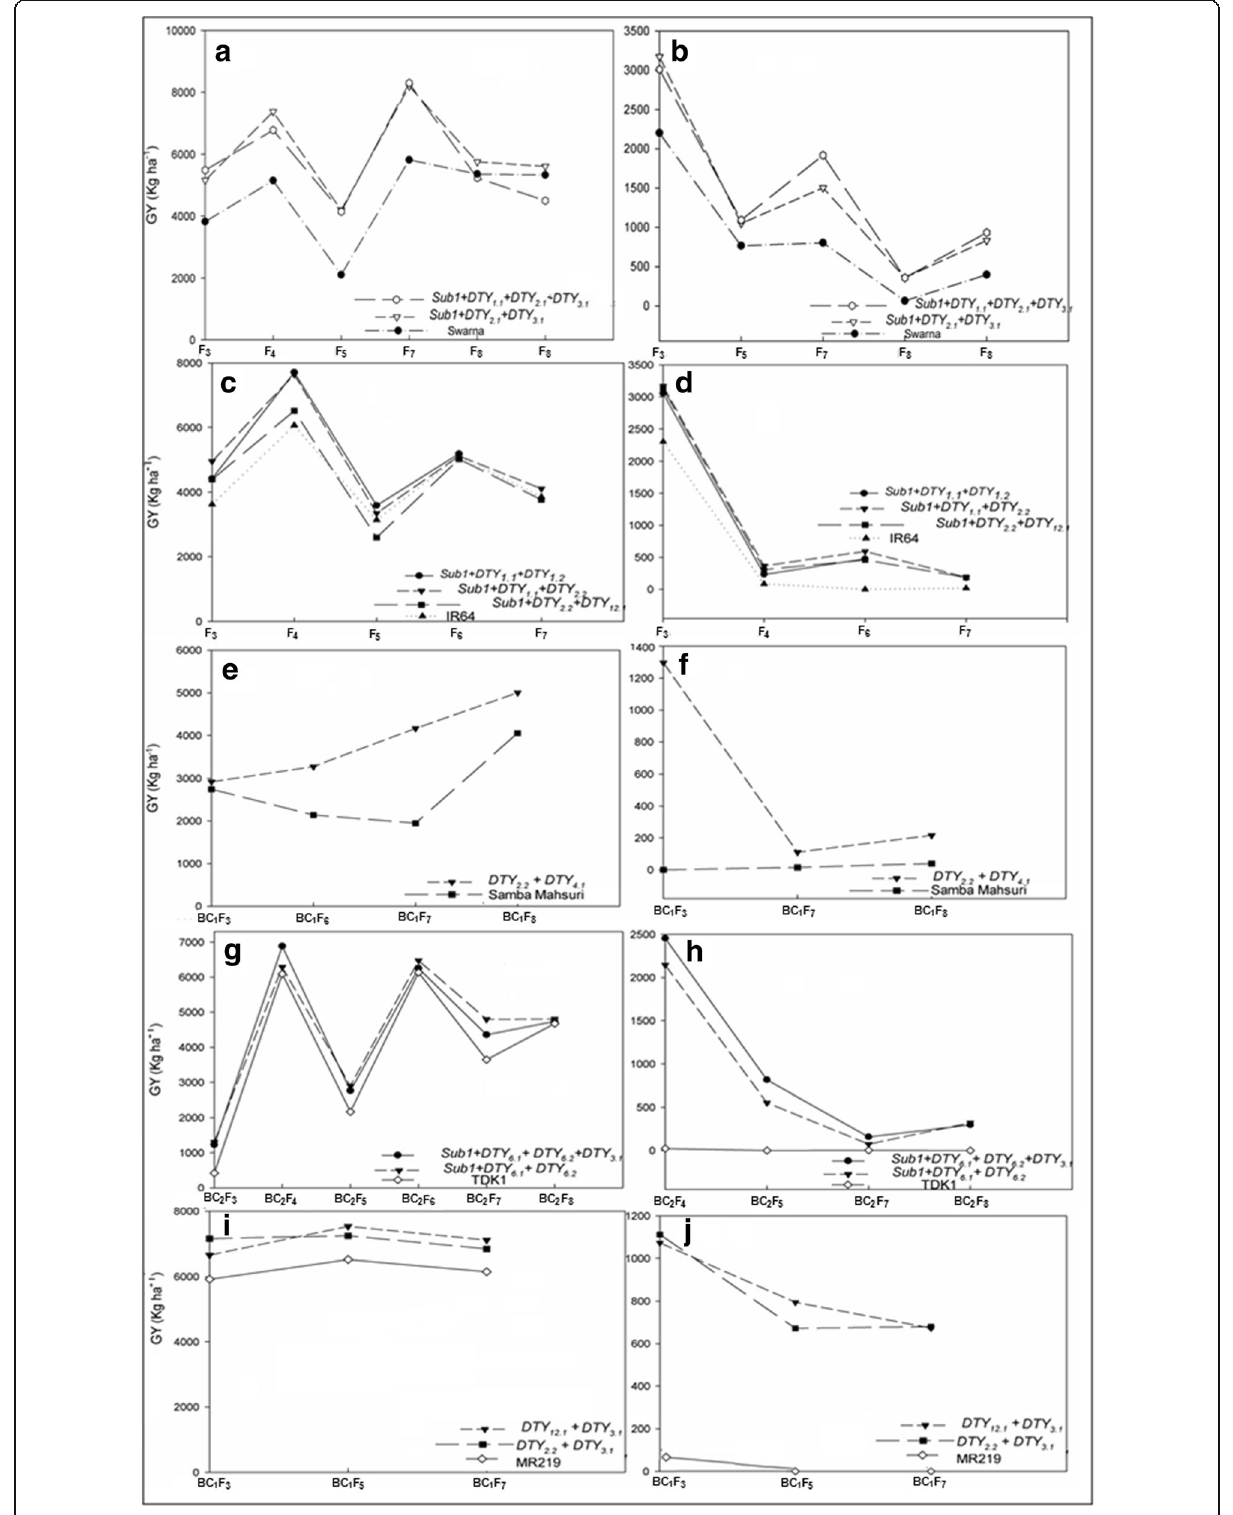
Fig. 1 (See legend on next